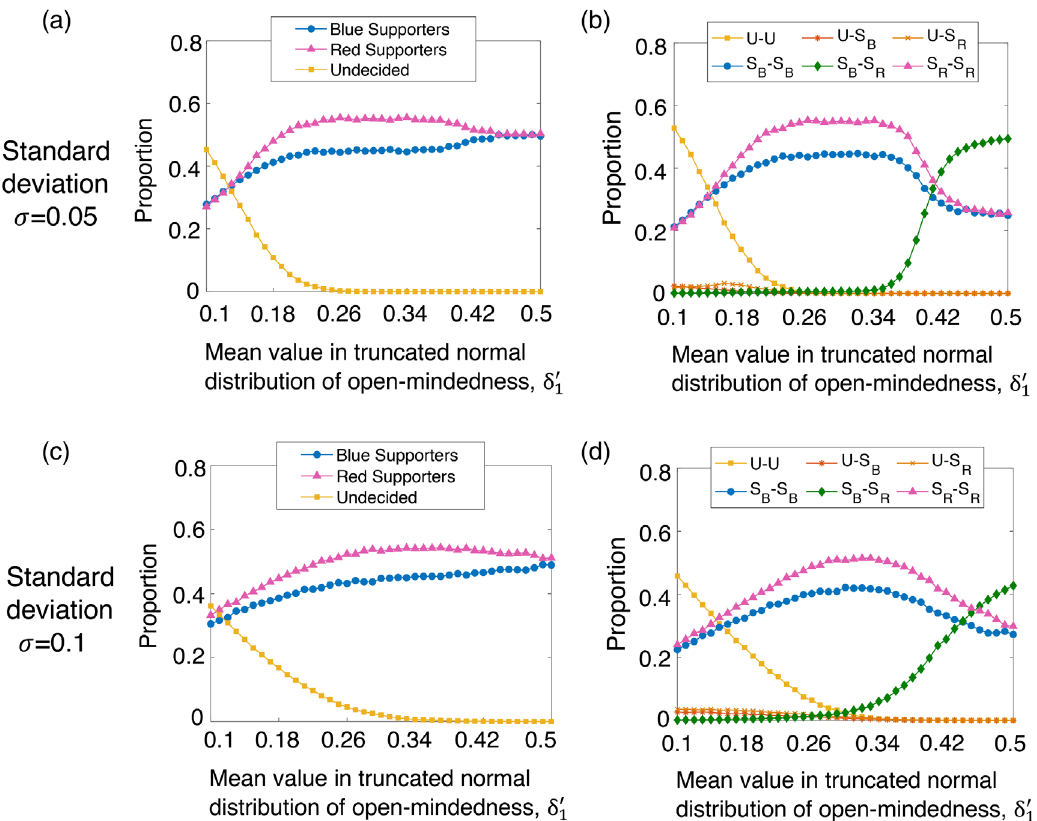
FIG. 9. Emergence of echo chambers with heterogenous levels of population open-mindedness. We relax the assumption of homogenous population open-mindedness ( δ 1 ) and instead allow a truncated normal distribution of open-mindedness ( δ 1 ;i ). As δ 0 1 increases, we observe (similar to the main model) that there are three phase stages divided by two transition points. Two opposing echo chambers are more likely to occur when individual open-mindedness δ 1 ;i surrounds a moderate δ 0 1 . Compared to mild heterogeneity (a),(b), strong heterogeneity allows for wavering individuals or independent clusters for slightly higher levels of mean open-mindedness (c),(d). Simulation results are averaged over 30 independent runs. Parameters: All simulations begin from an ER graph with N ¼ 10 4